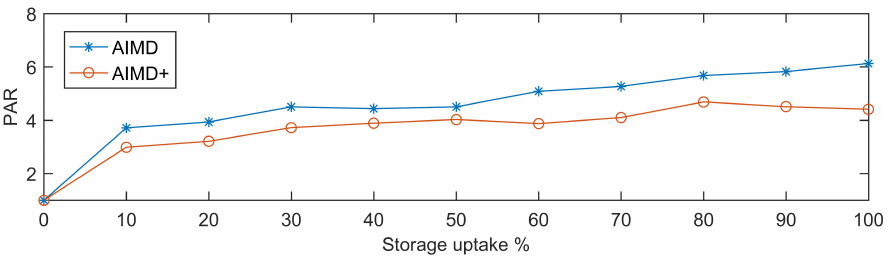
Figure 16. The performance index ζ ∗∗∗ storage